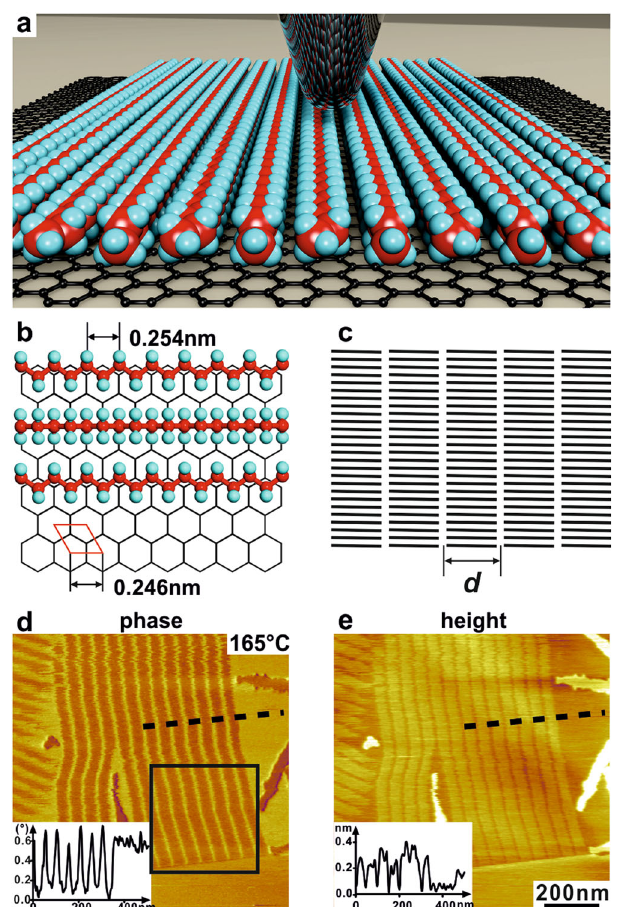
Fig. 2 Schematic models and AFM phase images of a n-C 390 H 782 monolayer on graphite. a An artist ’ s impression of an alkane monolayer on a graphite surface being probed by AFM. The sharpness of the AFM tip is not realistically presented for visual appeal. b Epitaxial arrangement of n- alkane chains on the graphite (001) surface. c 5 lamellae of 20 chains (schematic). d , e AFM phase and height images of a monolayer of n- C 390 H 782 at 165 °C, with the respective phase and height pro fi les along the dotted lines shown in the insets. The black square in ( d ) marks the region shown magni fi ed at different temperatures in Fig.